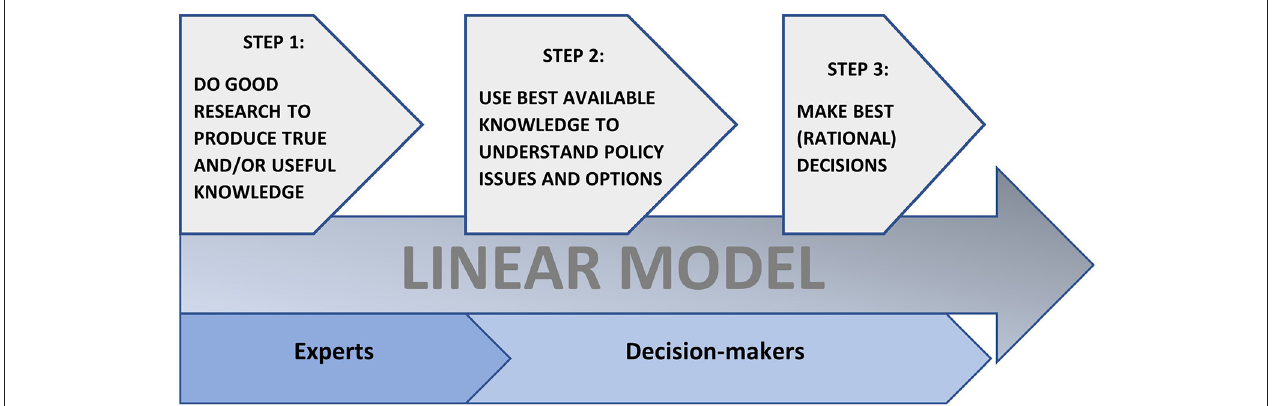
FIGURE 1 | The linear model of